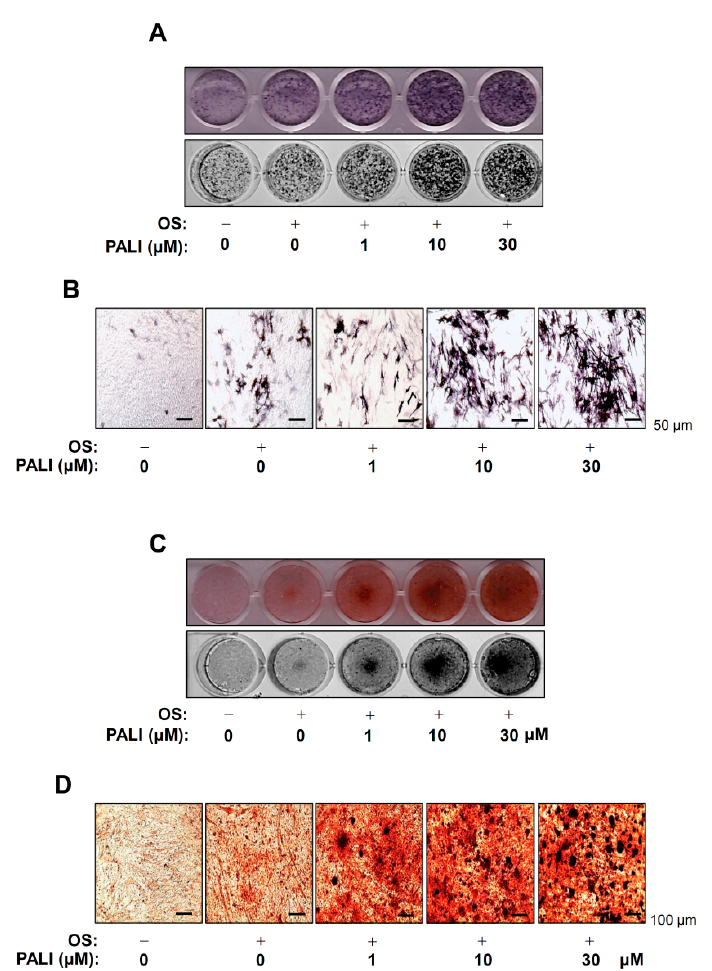
Figure 3. Effects of paeonolide (PALI) on the osteoblast differentiation of pre-osteoblasts. ( A , B ) Pre-osteoblasts were treated with the indicated concentrations of PALI during osteogenic supplement medium (OS)-induced osteoblast differentiation for seven days. Alkaline phosphatase (ALP) staining was analyzed under a scanner ( upper ) and a colorimetric detector ( bottom ) ( A ), and ALP-positive cells were visualized using a light microscope ( B ). Scale bar: 50 µ m. ( C , D ) The mineralized nodule formation was examined using Alizarin red S (ARS) staining at 14 days. The ARS staining was analyzed using a scanner ( upper ) and a colorimetric detector ( bottom ) ( C ), and the mineralization nodules were visualized using a light microscope ( D ). Scale bar: 100 µ m. Data are representative of the results of three independent experiments and values are expressed as mean ± SEM. *, p < 0.05 indicates statistically significant difference, compared with the control; #, statisti- cally significant difference compared with OS ( p < 0.05).